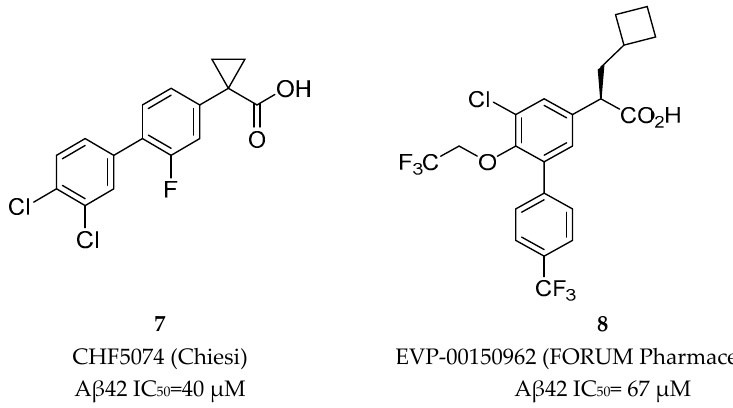
Figure 9. CHF5074 ( 7 ) and EVP-0015962 ( 8 ).